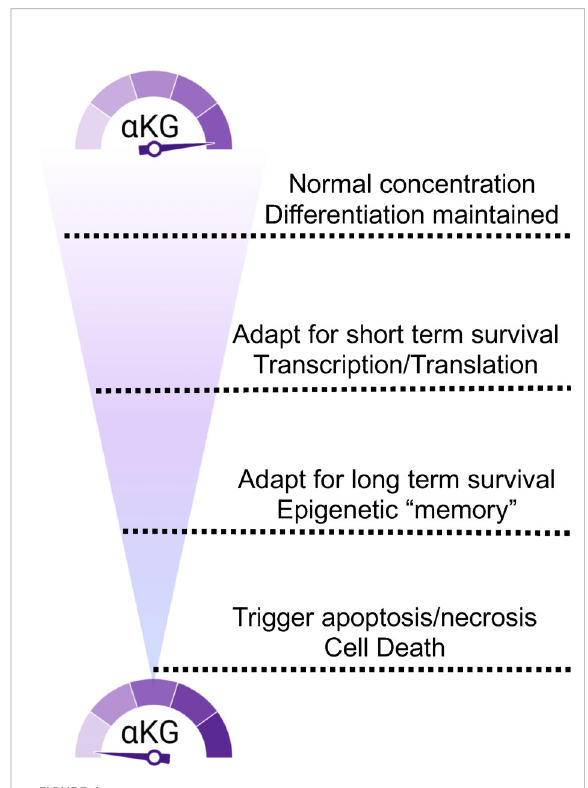
FIGURE 4 a KG concentration fl uctuations trigger a spectrum of cellular responses. Access to glutamine and a KG trigger responses that range from immediate need to epigenetic durability to